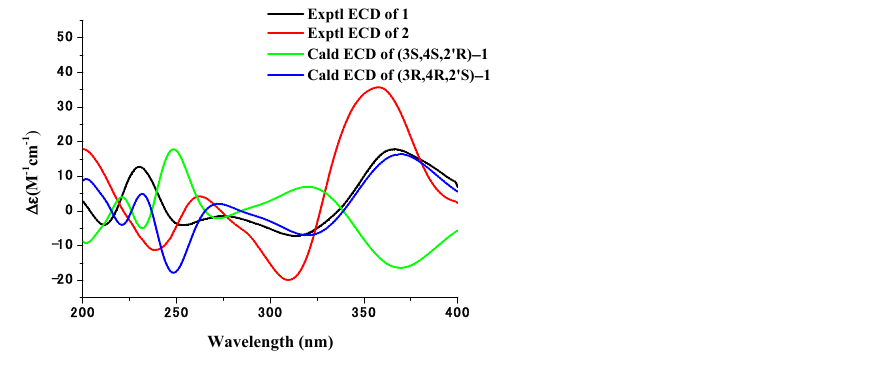
Figure 5. Linear regression analysis between experimental and calculated 13 C NMR chemical shifts